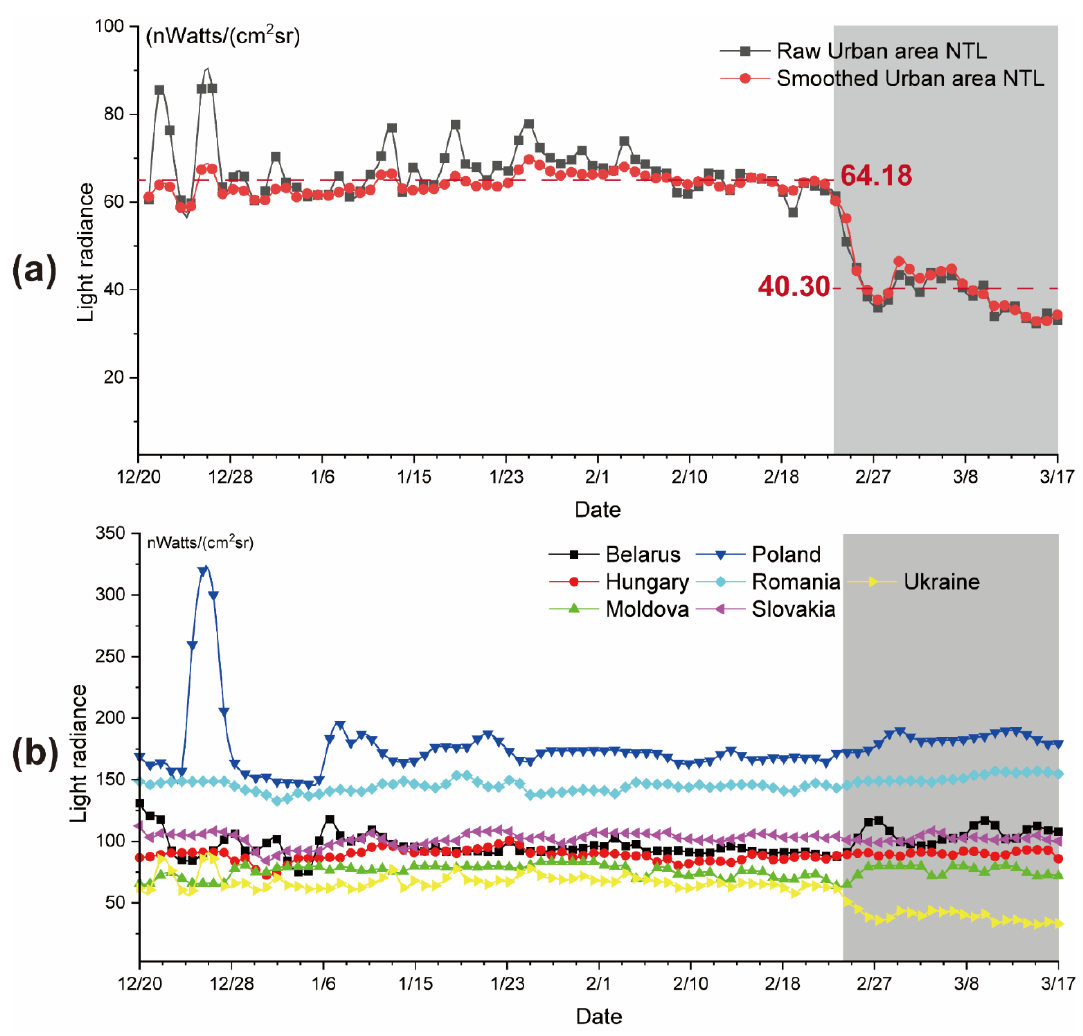
Figure 4. ( a ) Daily mean light radiation curve of the urban area of Ukraine and ( b ) Surrounding countries (gray background represents the period of conflict).